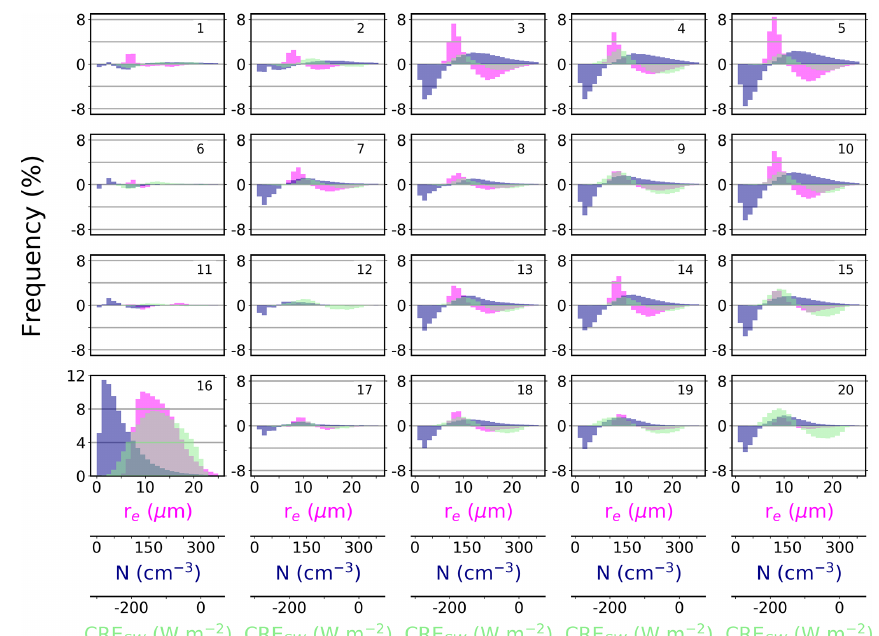
Figure 7. Frequency distributions of r e (µm; colored magenta), N (cm − 3 ; colored dark blue), and CRE SW (Wm − 2 ; colored light green) for each node over the ocean in the 4 × 5 SOM topology. The node number is shown in the top right corner of each subplot. The actual distributions are shown for node 16, while the difference relative to node 16 (node x minus node 16, where x is a given node) is shown for all other nodes. Therefore, smaller (larger) values indicate a deficit (surplus) relative to node 16. The distributions of r e and N are generated from the plan views in Figs. 4 and 5. The distribution of CRE SW is calculated from the plan view of τ (see Sect. 2.3), which is generated similarly to r e and N but is not shown here. Also, median values of each distribution are documented in Table